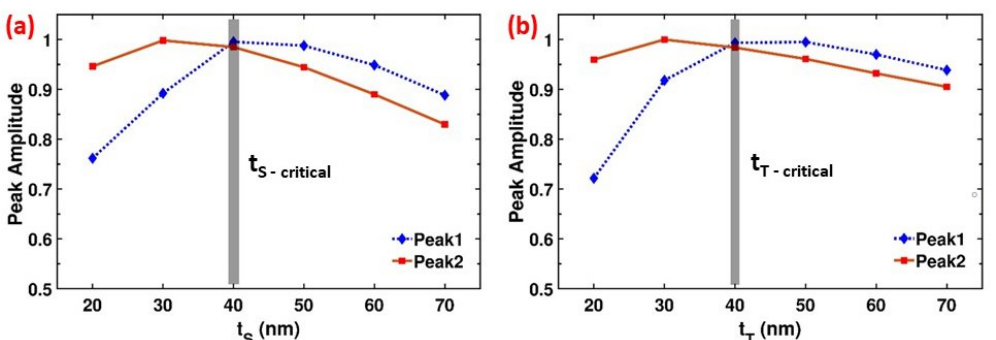
Figure 4. Dependence of the absorption peak amplitude on dielectric spacer thickness t S ( a ) and top nanodisc thickness t T ( b ) for both resonance modes. Shaded regions correspond to the critical coupling regime that occurs at t S-critical ( a ) and t T-critical ( b ), resulting in perfect absorption for both resonances. Above t T-critical the scattering on the nanodiscs become dominant and absorption decreases. Below and above t S-critical the coupling weakens, thus the absorption of the system is